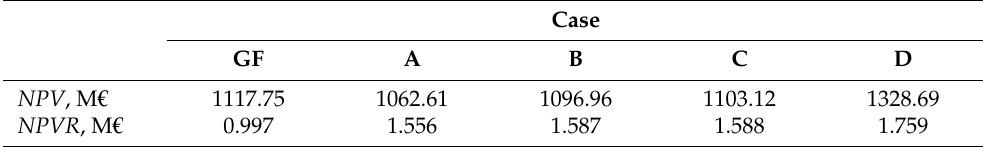
Table 7. Results of economic analysis for nominal assumptions.